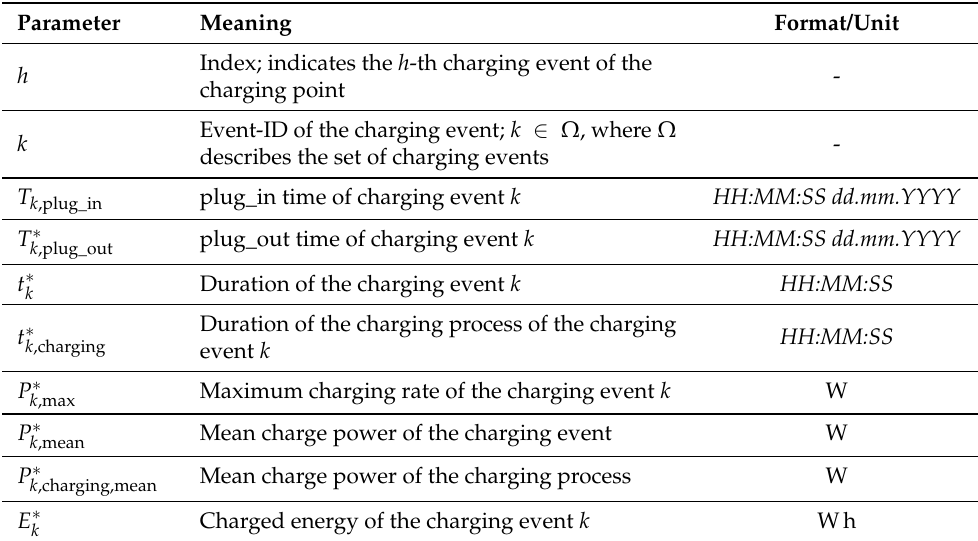
Table 1. Parameters of individual charging